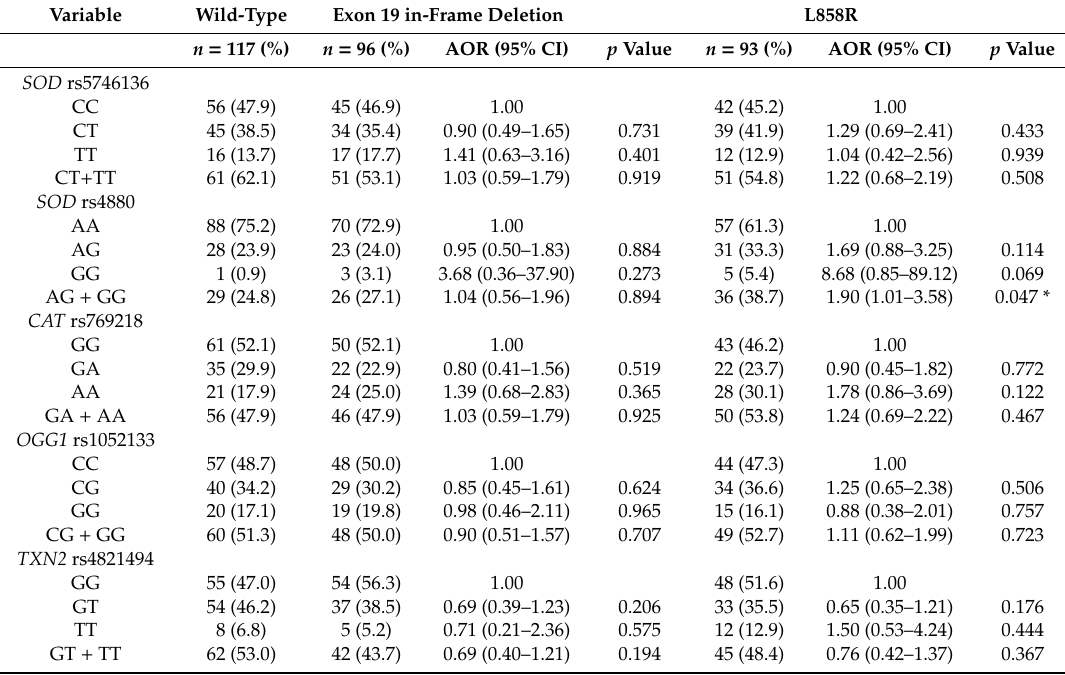
Table 3. Associations between antioxidant gene polymorphism and epidermal growth factor receptor hotspot mutations in lung